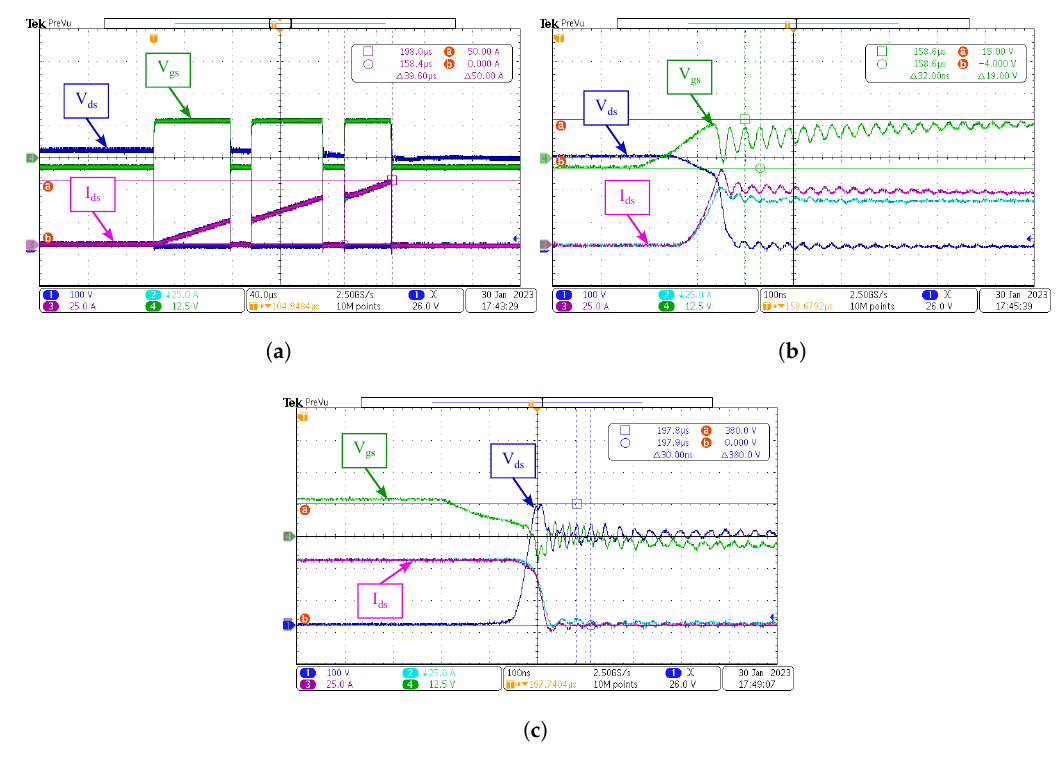
Figure 11. 2 µ F Ceralink capacitance on PCB, ( a ) Triple pulse test waveform, ( b ) Gate waveform, ( c ) Drain source voltage waveform. −